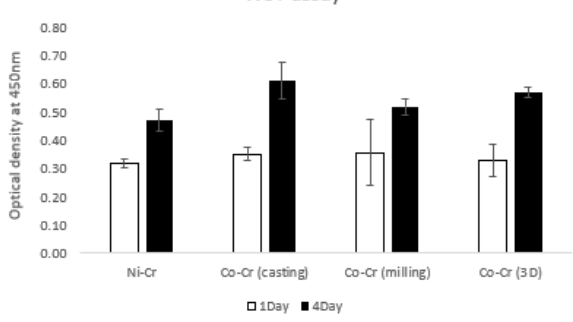
Figure 7. The water-soluble tetrazolium salt (WST) assay of hADSCs cultured on the disks on day 1 and day 4. The value of Ni-Cr was significantly lower than that of other groups both for day 1 and day 4. There were no significant differences between the groups of Co-Cr disks for day 1. There was no significant difference between the Co-Cr (casting) and Co-Cr (3D) groups for day 4 (the bar represents mean ± SD).